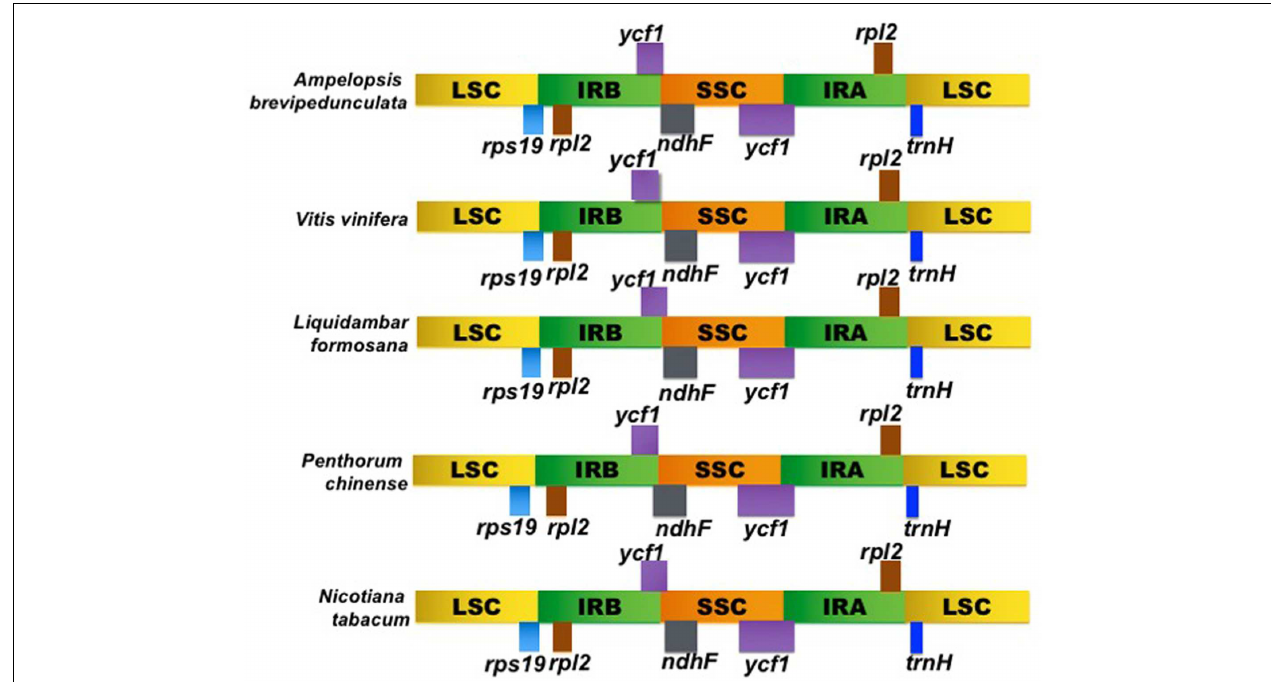
FIGURE 3 | Comparison of the borders of the LSC, SSC, and IR regions of Ampelopsis brevipedunculata , Vitis vinfera , Liquidambar formosana , Penthorum chinense, and Nicotiana tabacum cp